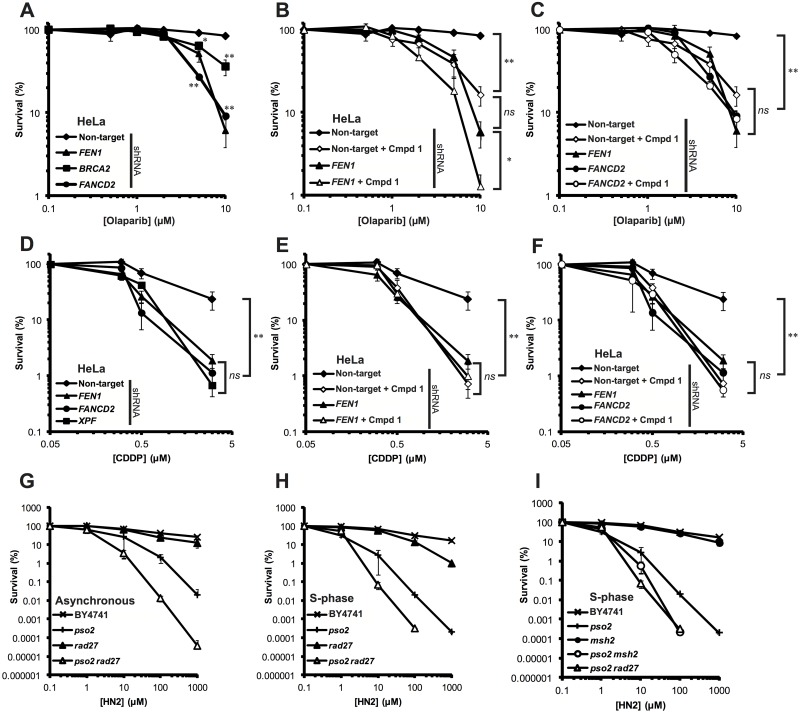
FEN1 is epistatic with FANCD2 for the repair of olaparib- and cisplatin-induced DNA damage.A. Olaparib sensitivity of cells disrupted for FEN1, FANCD2 or BRCA2 by shRNA compared to a non-target control. B. Sensitisation of cells to olaparib following treatment with 10 μM 1. C. Epistasis analysis of FEN1 inhibition and FANCD2 depletion following exposure to olaparib. D. Cisplatin sensitivity of cells disrupted for FEN1, XPF and FANCD2 by shRNA compared to a non-target control. E. Sensitisation of cells to cisplatin following treatment with 5 μM 1. F. Epistasis analysis of FEN1 inhibition and FANCD2 depletion following exposure to cisplatin. G-I. Sensitivity of Saccharomyces cerevisiae strains deleted for rad27, pso2, msh2 singularly and in combination either in asynchronous culture (G) or synchronised in S-phase (H-I). In all cases, each data point is the mean of at least 3 individual repeats and the error bars represent the standard error. Significance was determined by student t-test. ns = not significant * p < 0.05. ** p < 0.005.